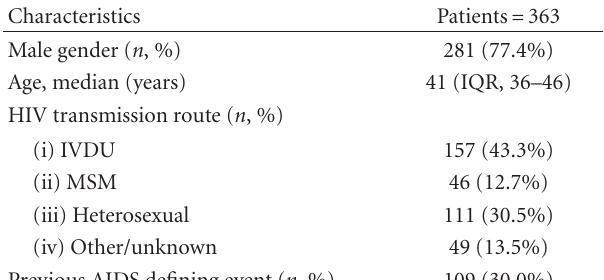
Table 1: General characteristics of the 363 HIV-positive patients included in the